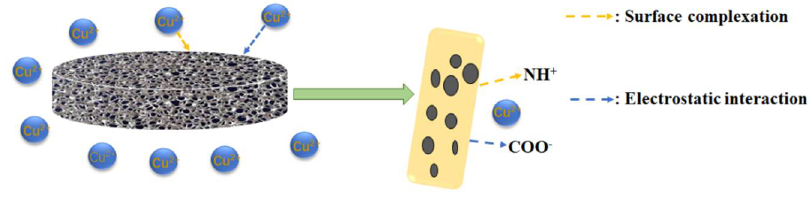
Figure 7. Schematic illustration of the adsorption mechanism of the CMCNFs-PEI.